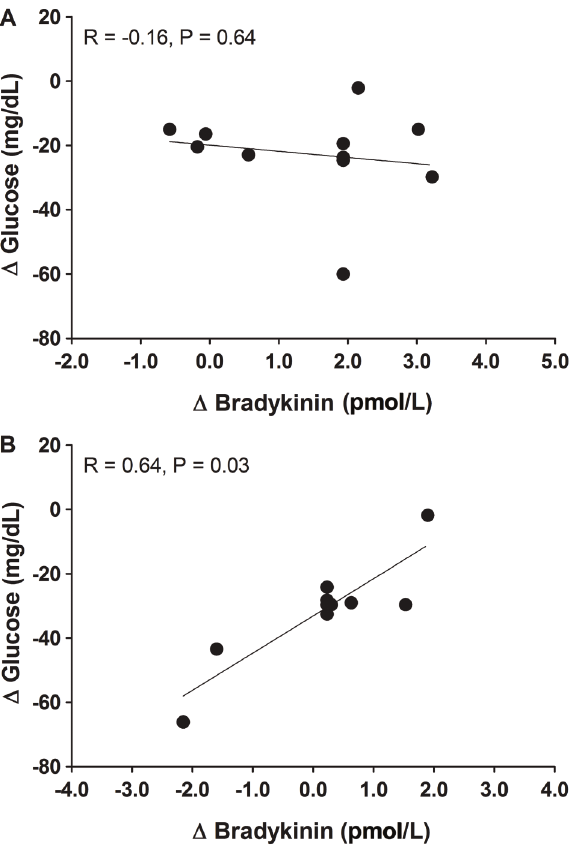
Figure 4. Spearman ’ s correlation coef fi cient between absolute change [rec 45 min – rest] of blood glucose and bradykinin in the conditions of exercise at 80% of lactate threshold ( A ) and at 120% of lactate threshold ( B